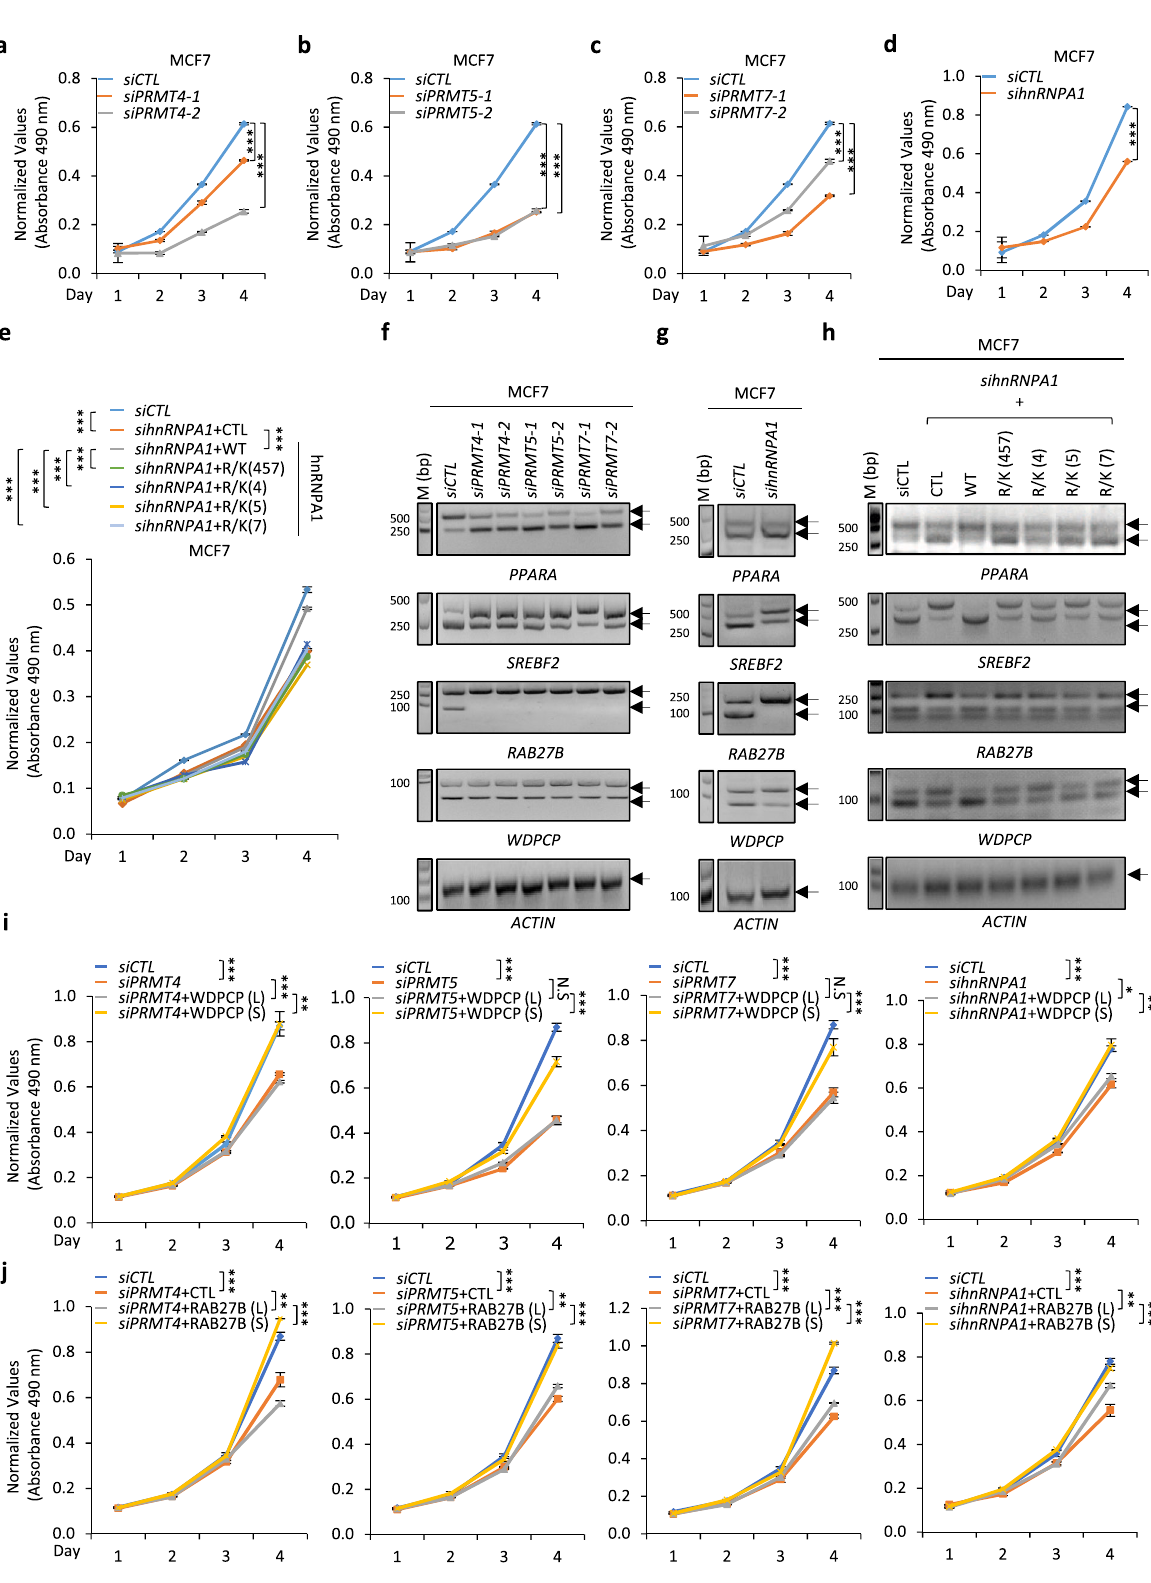
nants of the cellular response to PRMT5 inhibition. They sug- gested that the p53 – MDM4 regulatory axis de fi nes a subset of patients that could bene fi t from treatment with GSK3326595 81